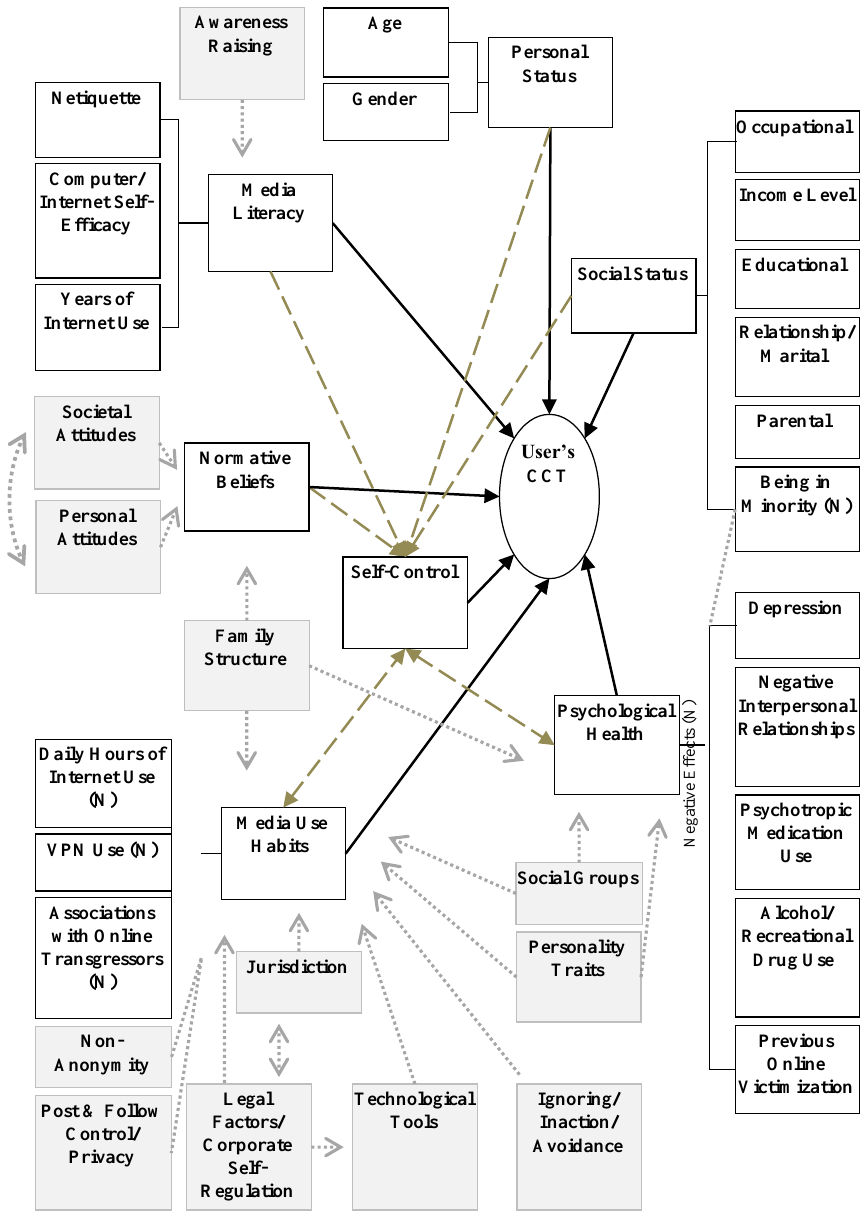
Figure 2: The Model of Effective Means of Cyber Social Control for Iranian Users’ Cybercultural Transgressions